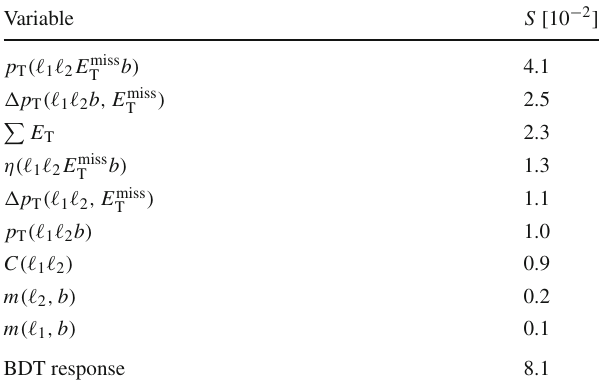
Table 2 The variables used in the signal region BDT and their sep- aration power (denoted S ). The variables are derived from the four- momenta of the leading lepton ( (cid:6) 1 ), sub-leading lepton ( (cid:6) 2 ), the b -jet ( b ) and E miss . The last row gives the separation power of the BDT T discriminant response